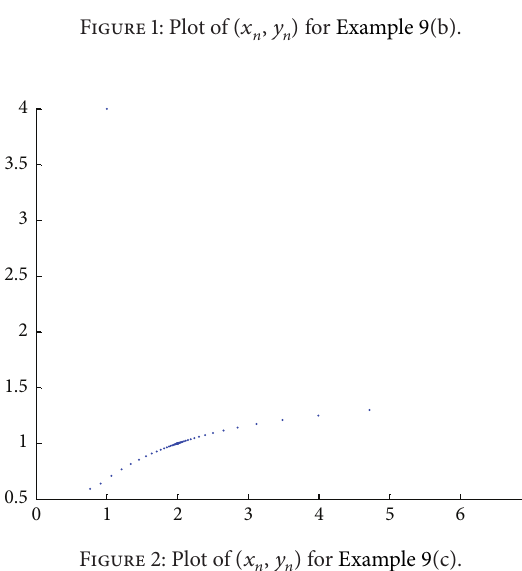
Figure 1: Plot of (𝑥 𝑛 , 𝑦 𝑛 ) for Example 9(b).